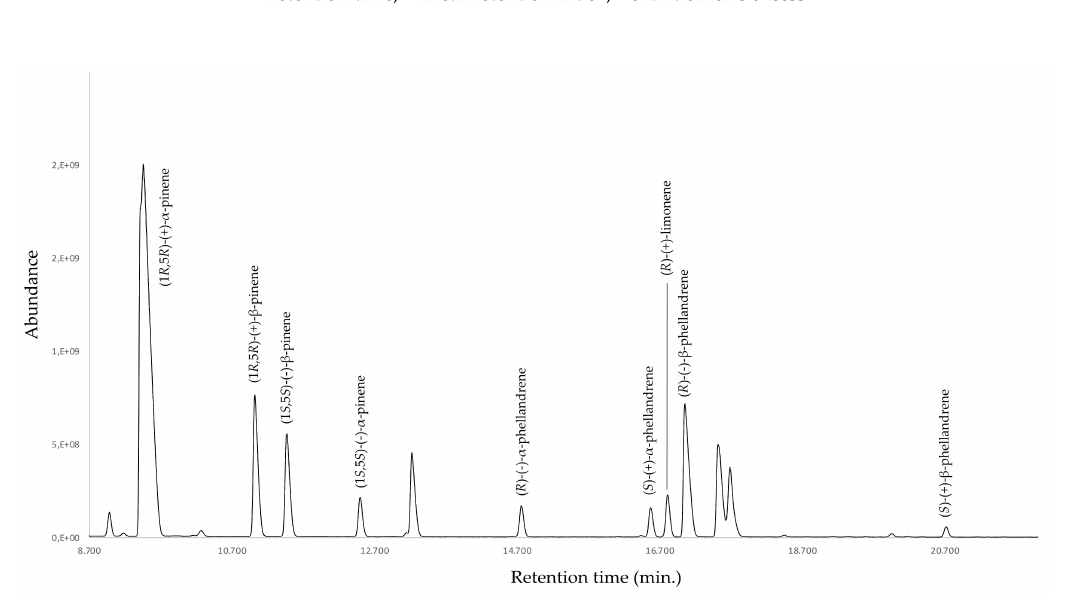
Figure 1. Enantioselective chromatogram of D. mutisii EO with 2,3-diethyl-6- tert -butyldimethylsilyl- β -cyclodextrin